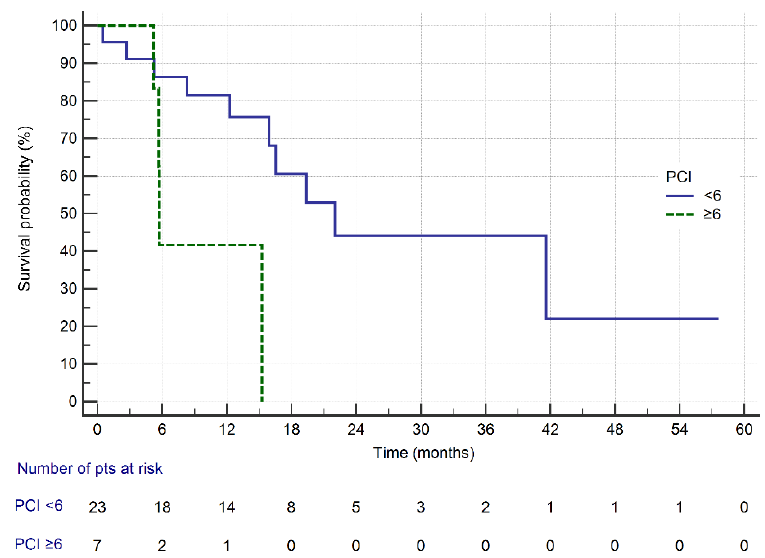
Figure 4. Overall survival of GC patients treated with CRS + HIPEC depending on the PCI with cut-off value of 6 ( p = 0.01; log-rank test).